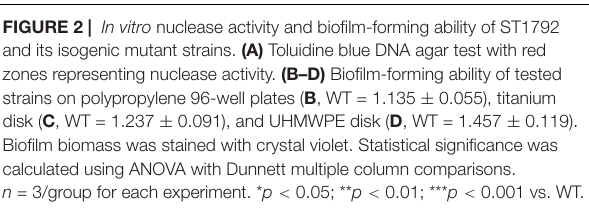
FIGURE 2 | In vitro nuclease activity and biofilm-forming ability of ST1792 and its isogenic mutant strains. (A) Toluidine blue DNA agar test with red zones representing nuclease activity. (B–D) Biofilm-forming ability of tested strains on polypropylene 96-well plates ( B , WT = 1.135 ± 0.055), titanium disk ( C , WT = 1.237 ± 0.091), and UHMWPE disk ( D , WT = 1.457 ± 0.119). Biofilm biomass was stained with crystal violet. Statistical significance was calculated using ANOVA with Dunnett multiple column comparisons. n = 3/group for each experiment. * p < 0.05; ** p < 0.01; *** p < 0.001 vs.